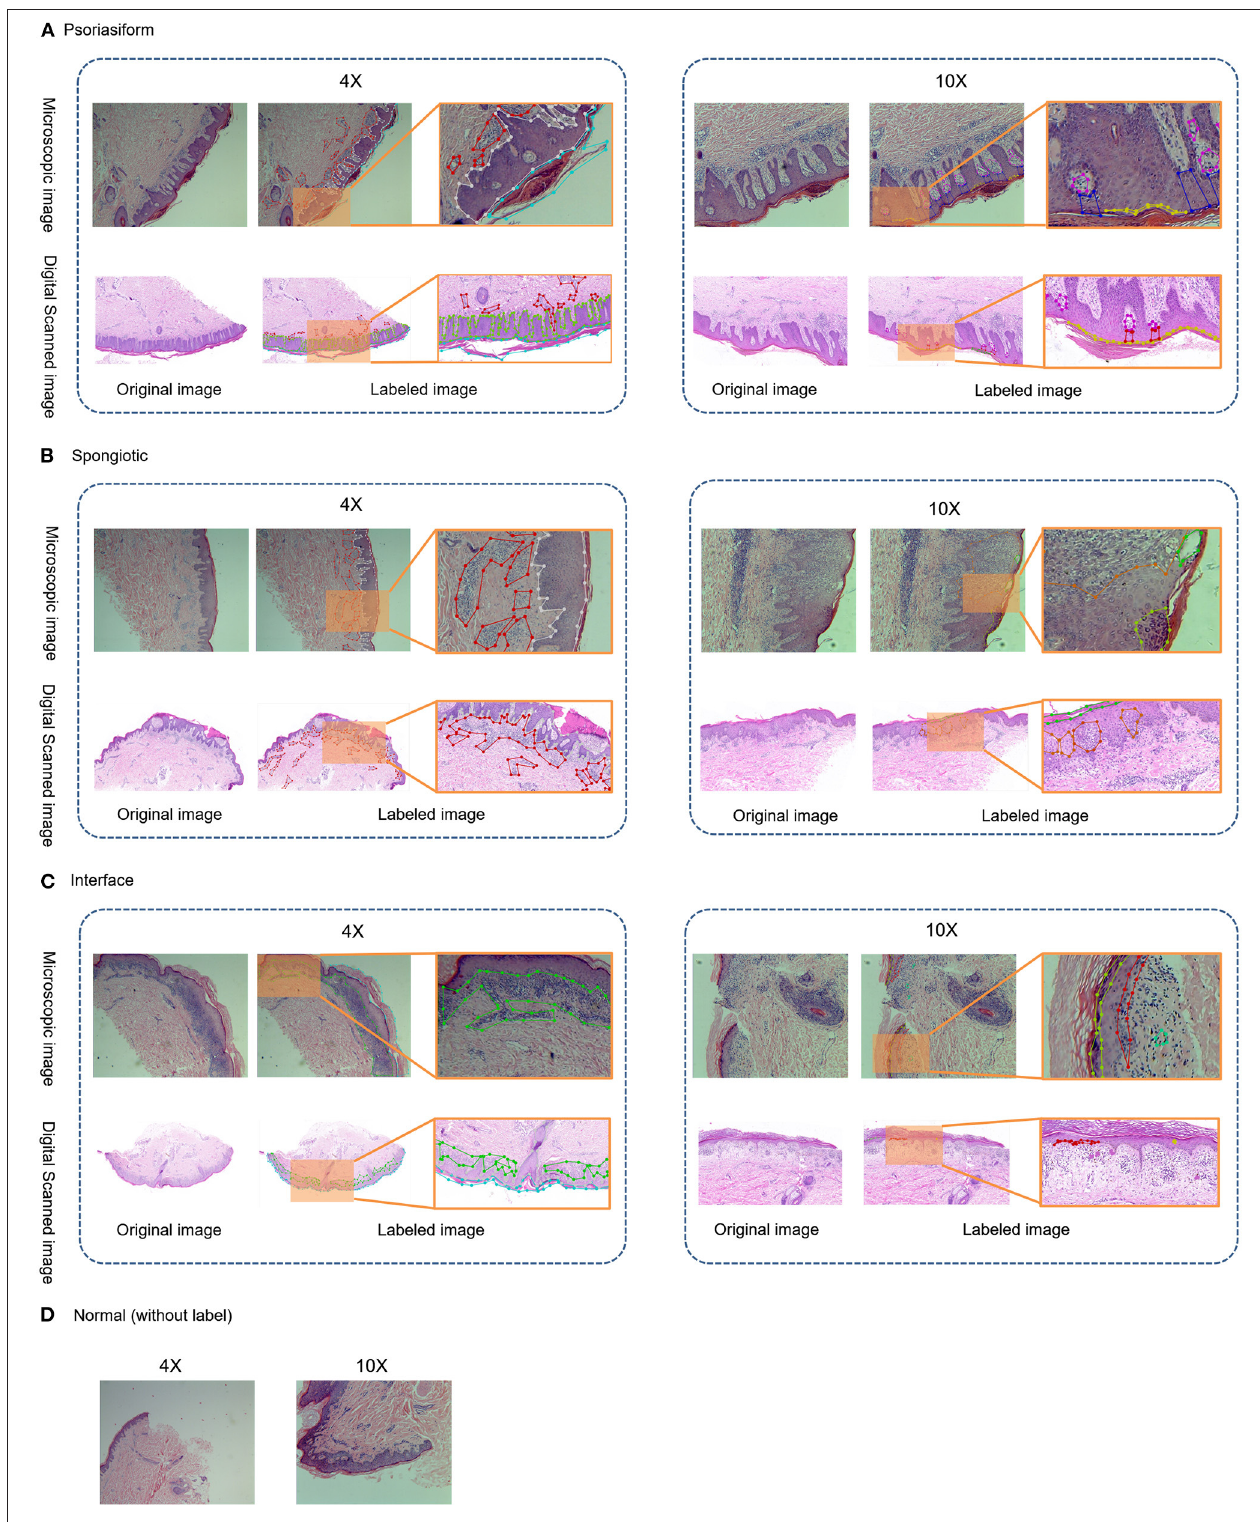
FIGURE 1 | Original and labeled images of different subtypes of superficial perivascular dermatitis. (Note: The labels refer to Table 2 and the generated annotation information of the labeled image is in the json file).